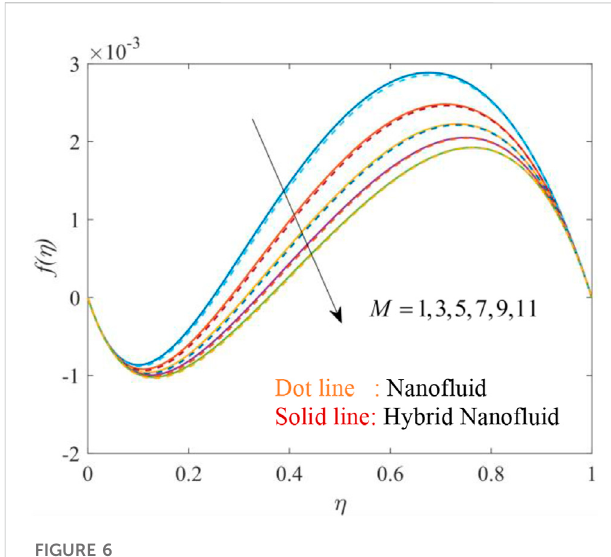
FIGURE 4 Effect of porosity parameter λ on f ′ ( η ) .